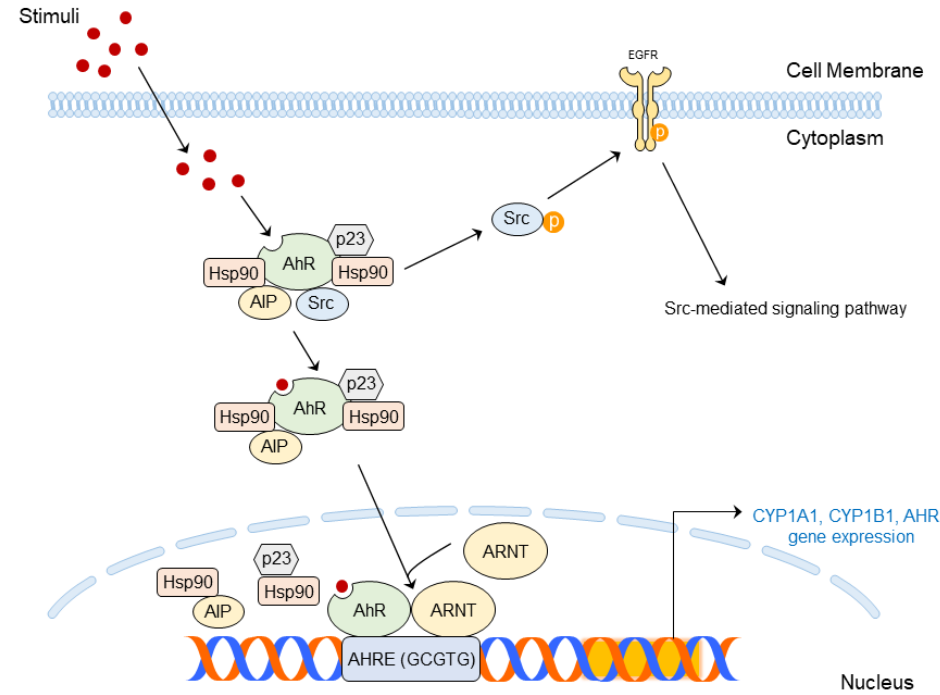
Figure 3. AhR-mediated signaling pathways in skin inflammation and skin cancer. Figure 3. AhR - mediated signaling pathways in skin inflammation and skin cancer.